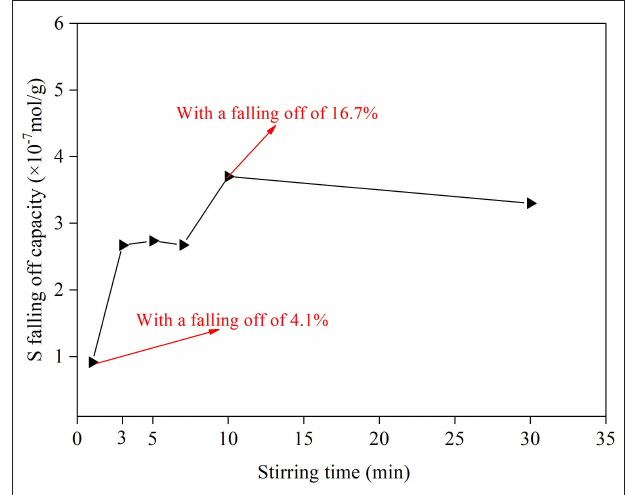
FIGURE 3 | S falling off capacity of smithsonite surface with stirring time.